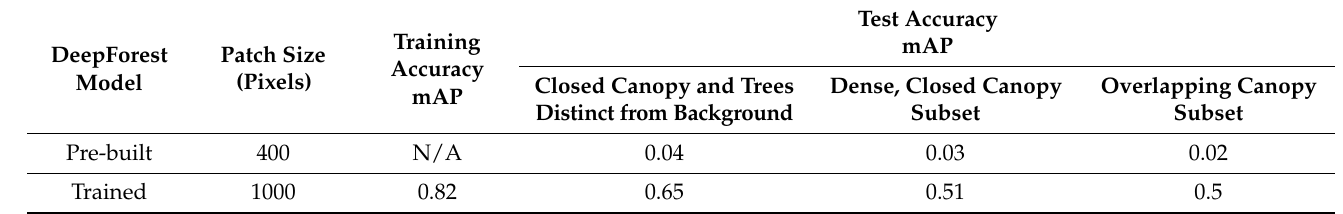
Table 3. Accuracies of the pre-built model and model trained with tree bounding boxes from the study. Training the pre-built model with a small subset drastically improved